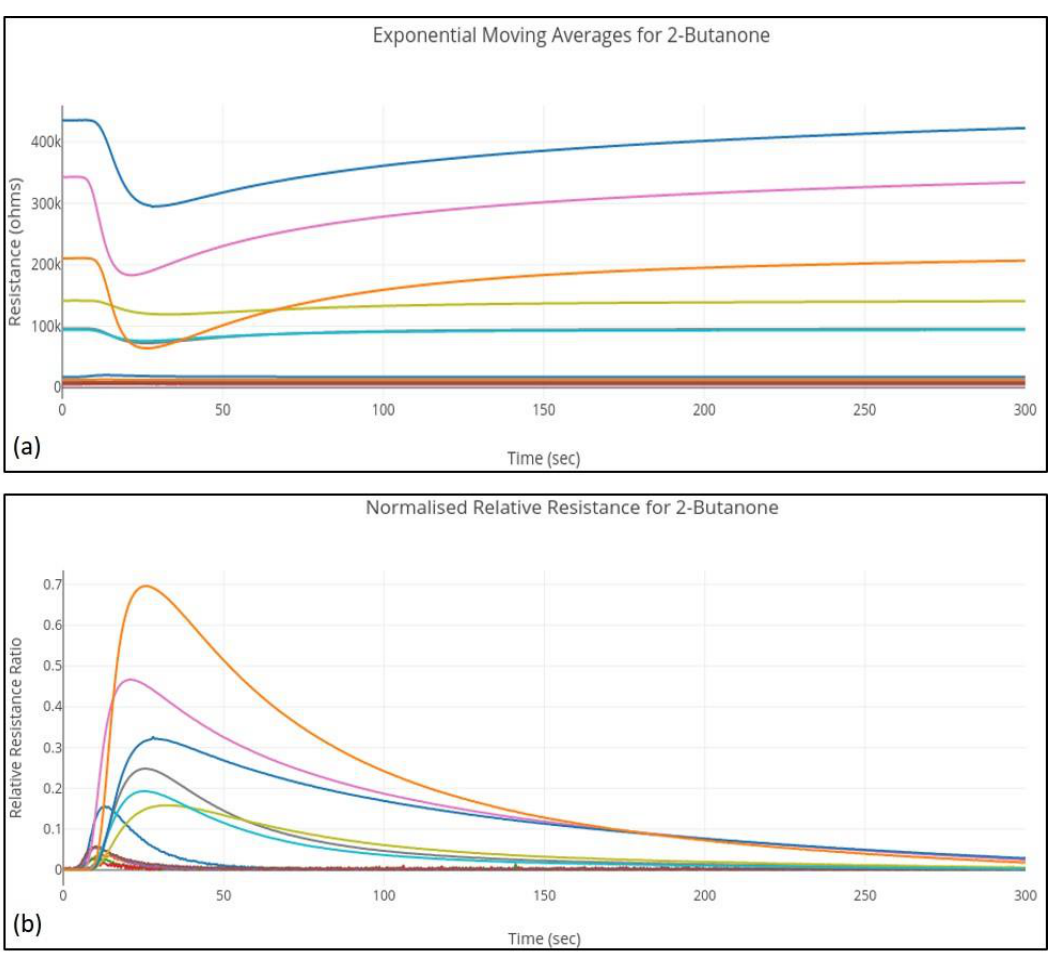
Figure 2. Feature sets for 2-Butanone sample. ( a ) Exponential moving averages. ( b ) Normalized relative resistance.